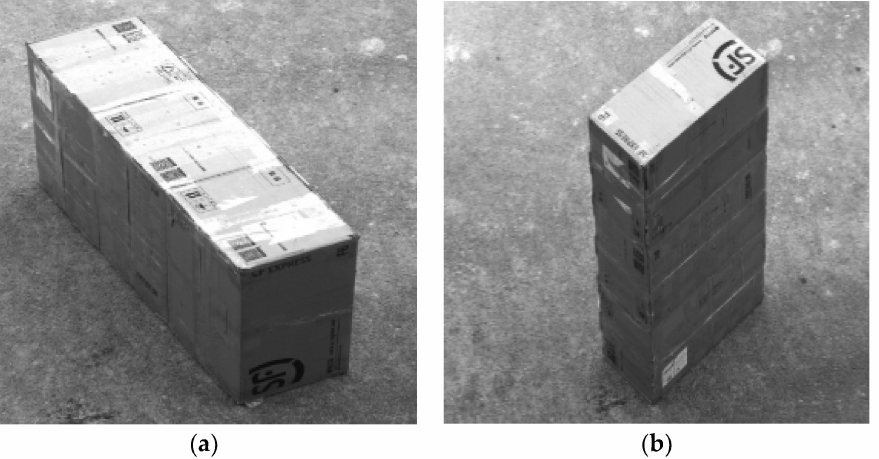
Figure 3. Illustration: ( a ) calibration box verification picture 1; ( b ) calibration box verification picture